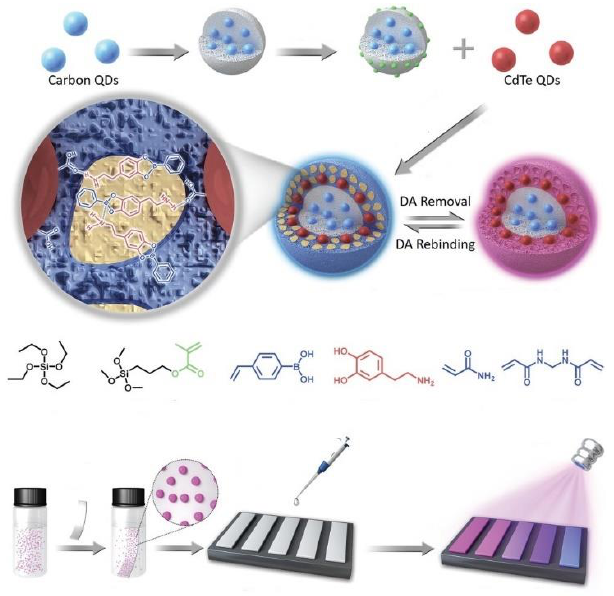
Figure 10. Schematic illustration of molecularly imprinted nanoparticles for dual emission detection of dopamine and the visual readout test strip. Adapted with permission [133]. Copyright 2019, Wiley-VCH.